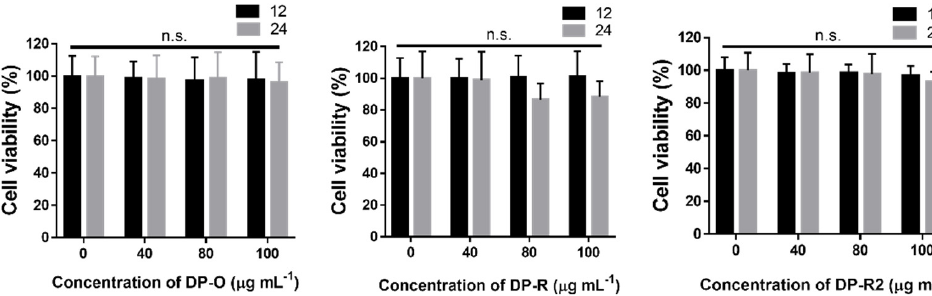
Figure 10. Biocompatibility estimation of AIE NPs at different concentrations with HeLa cells for 12 h and 24 h ( p > 0.05, n.s.: no significance).